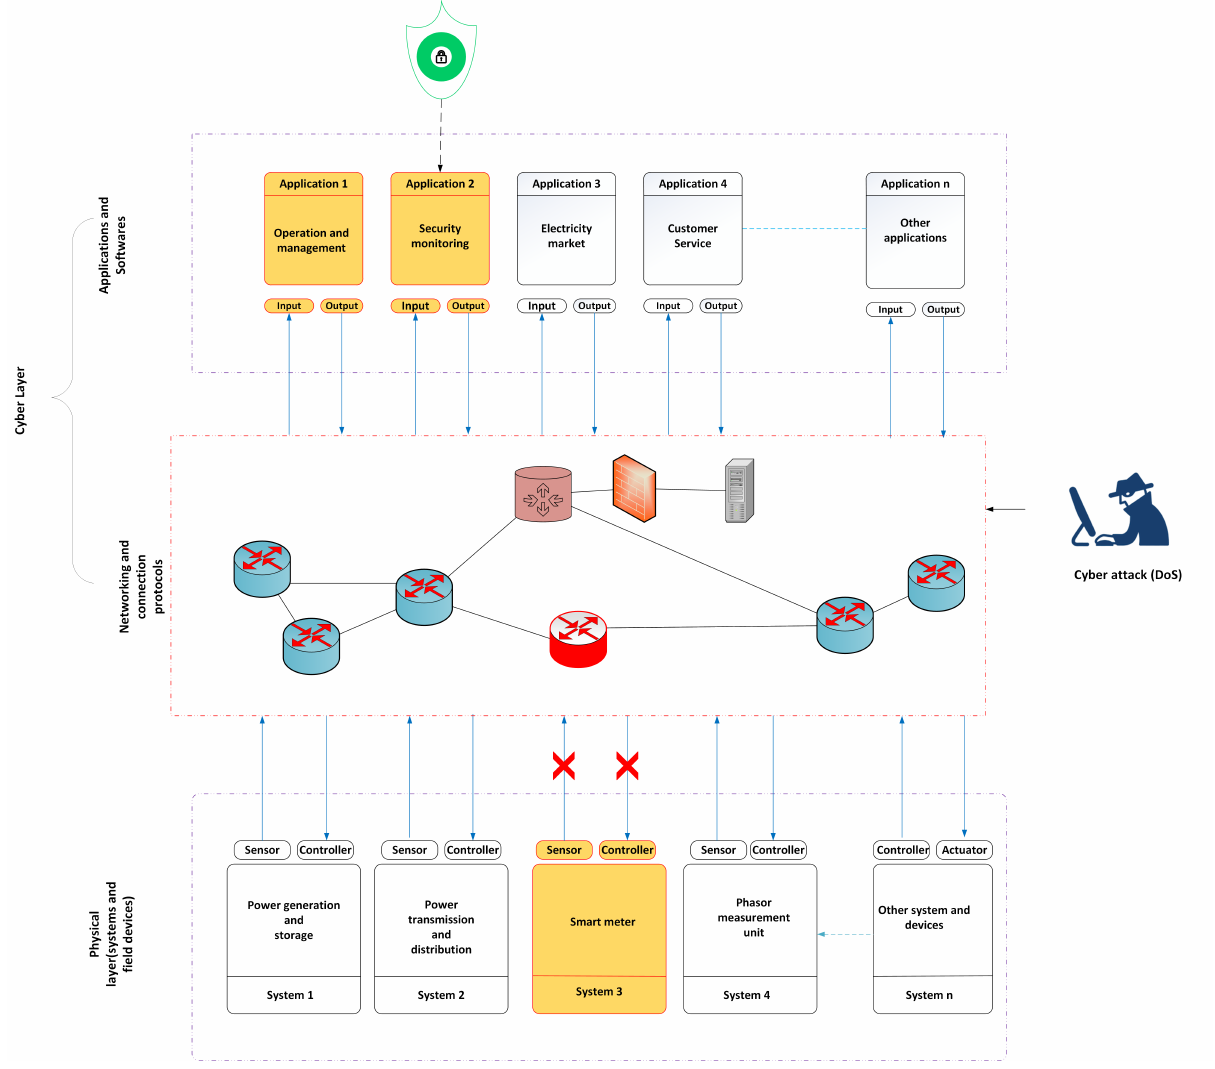
Figure 4. Schematic representation of the denial of service